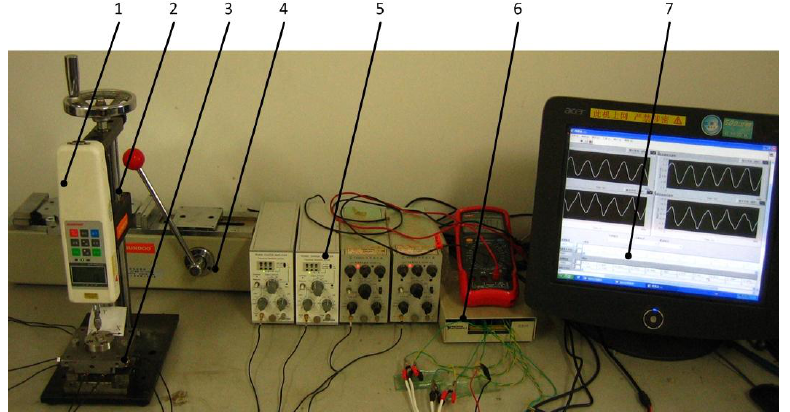
Figure 5. Photo of the static calibration test system: (1) Static standard power